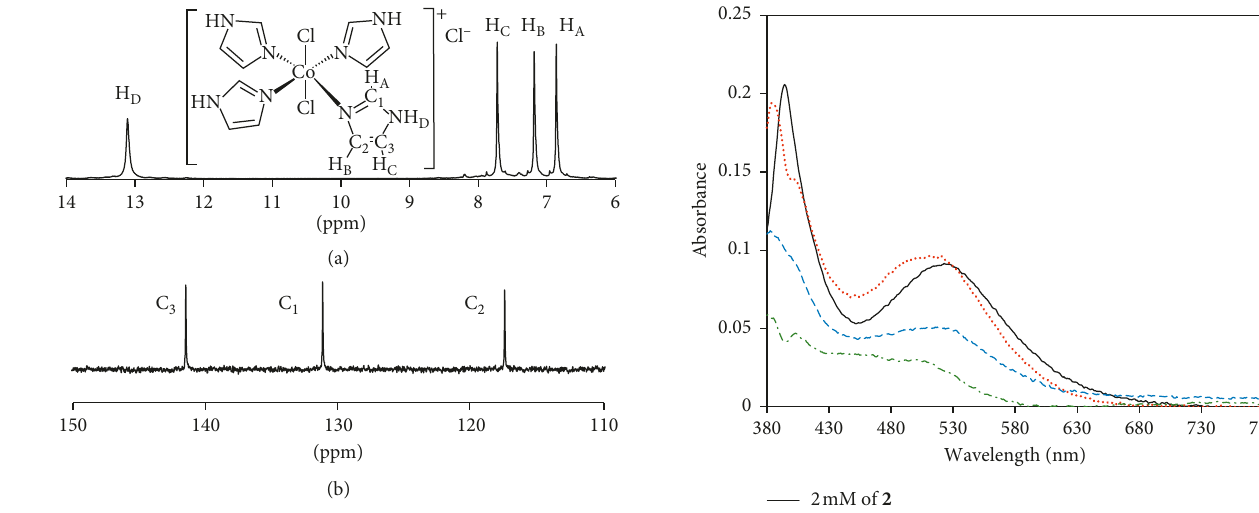
Figure 2: 1 H · NMR (a) and 13 C · NMR (b) of 2 in DMSO- d